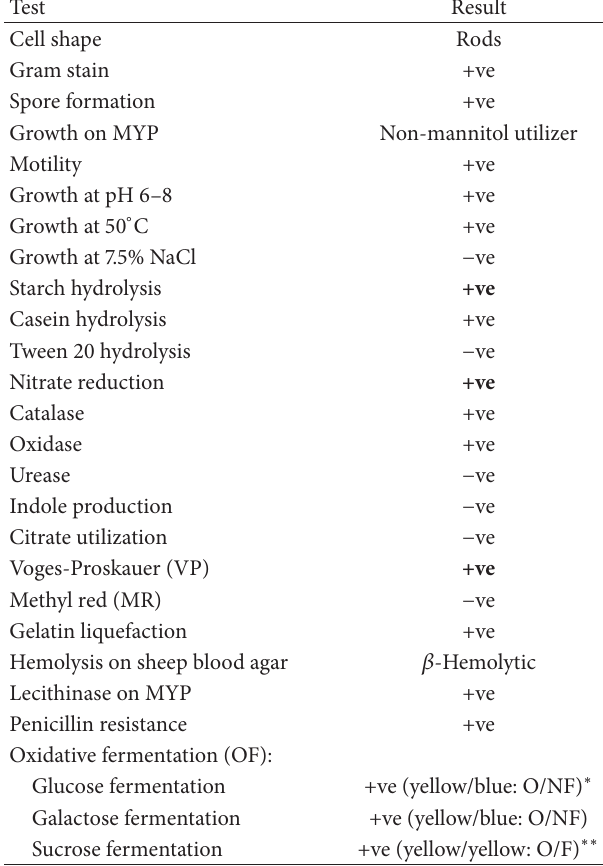
Table 2: Morphological and biochemical identification of S9 bacte- riocin producing bacterial isolate.